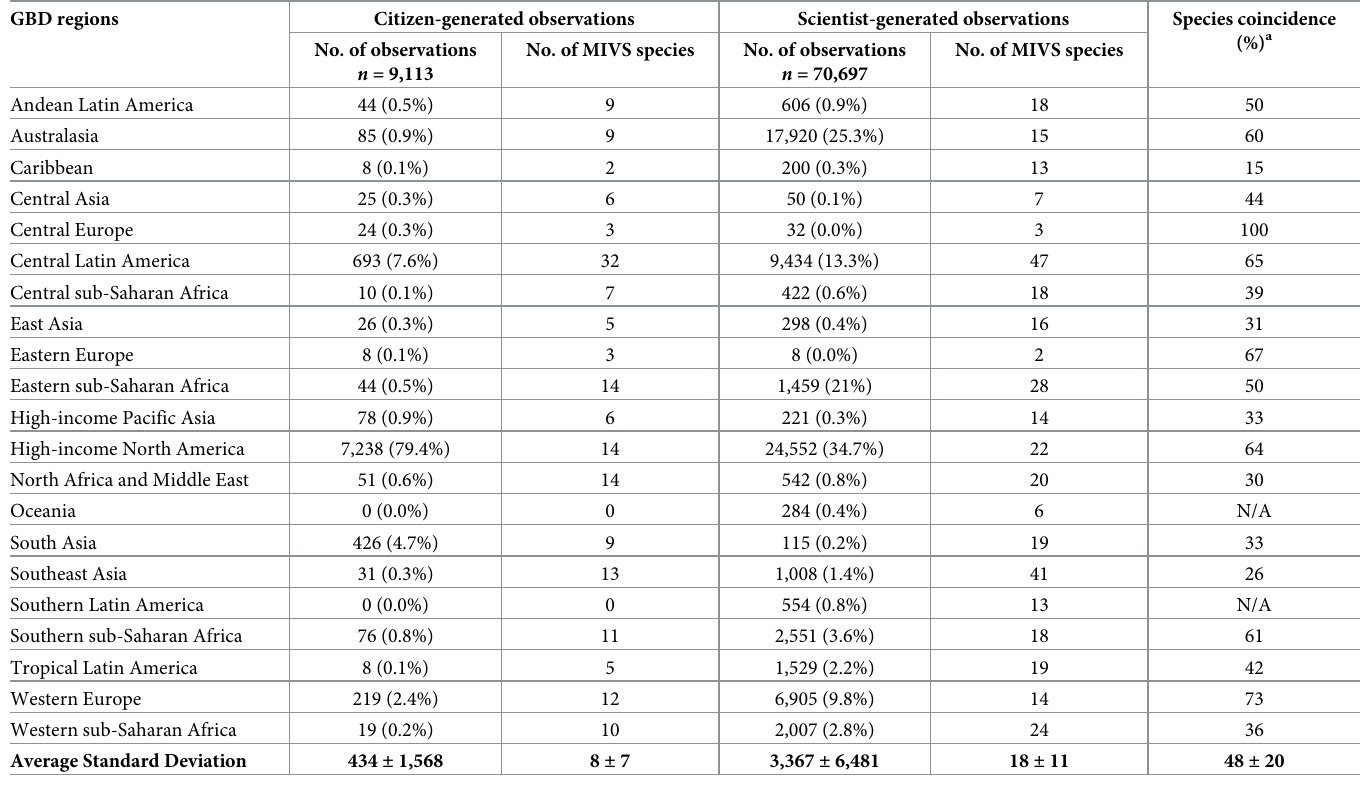
Table 2. Geographical distribution of citizen-generated and scientist-generated snake species